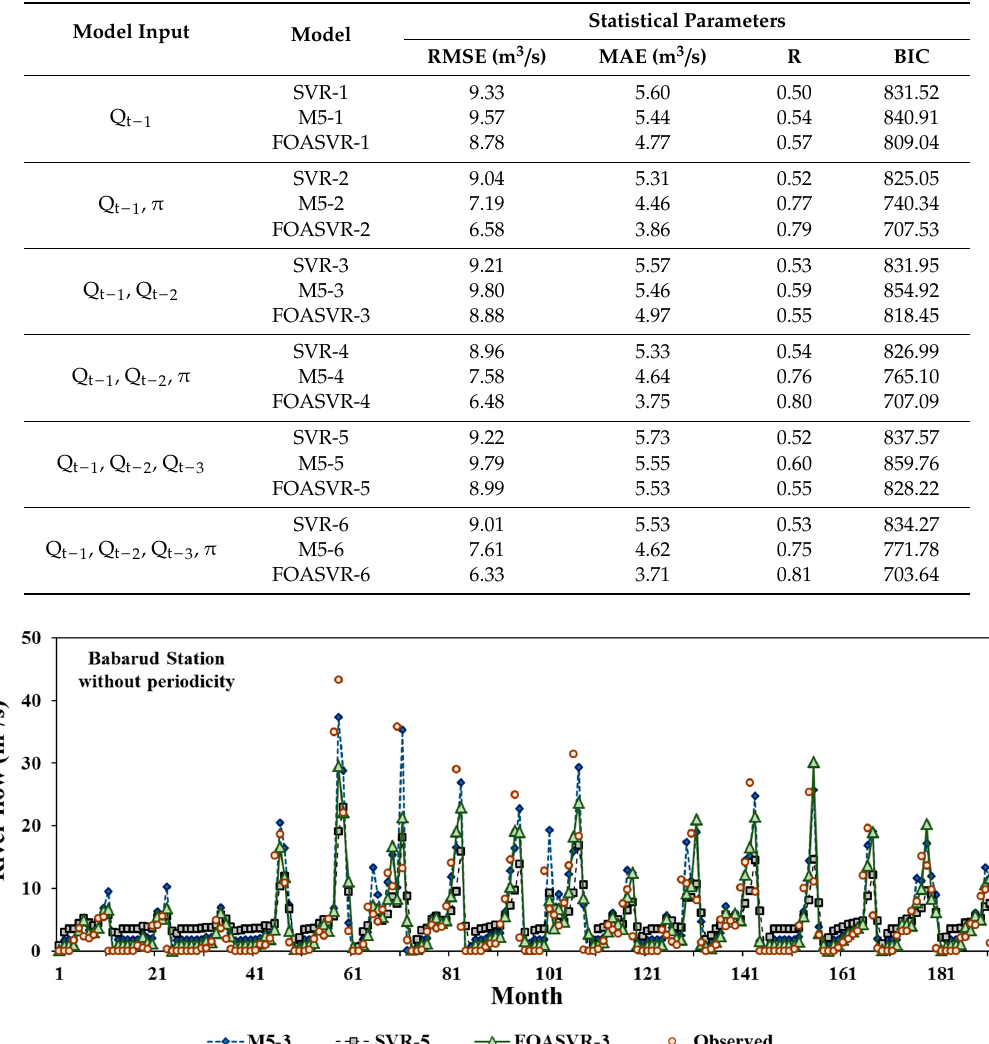
Figure 5. The observed and forecasted monthly river flows for Babarud station without periodicity.